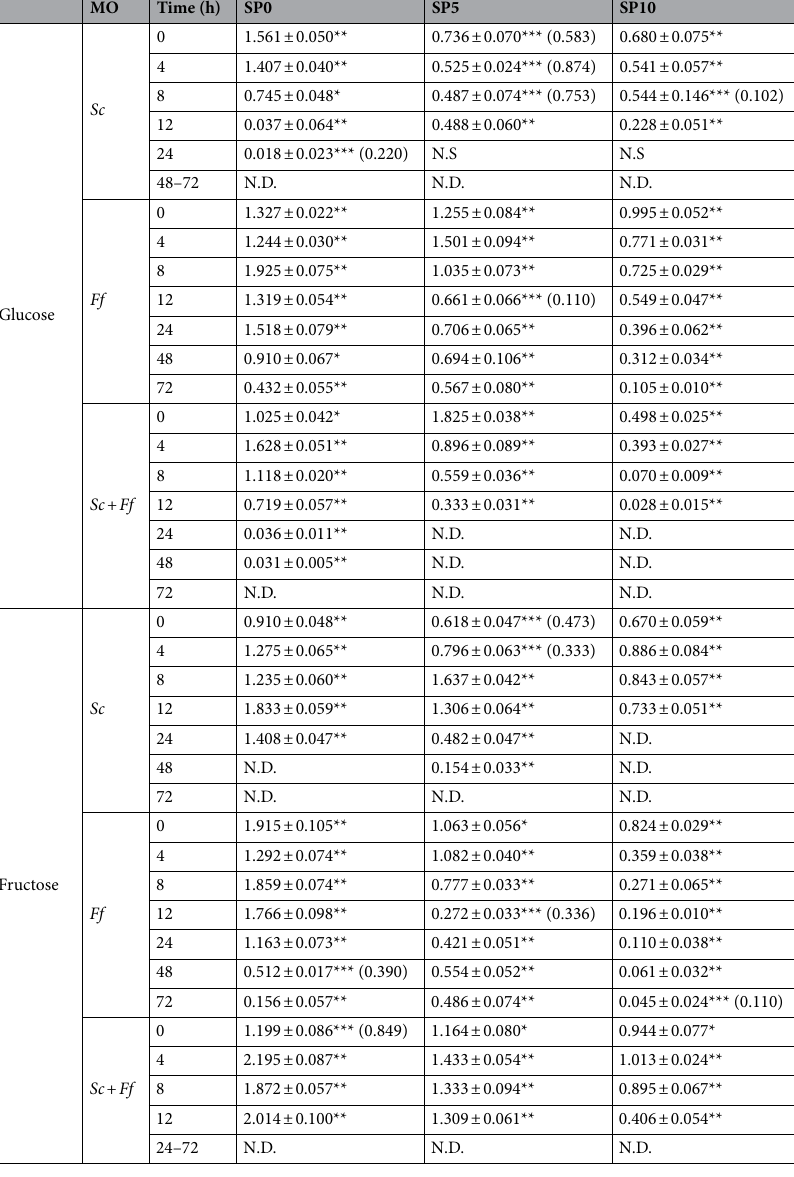
Table 1. Monosaccharides concentration through fermentation (g/L). Results (displayed as mean values ± SD, g/L, n = 3). Data normality was investigated applying the Shapiro-Whilk test. For values, p > 0.05,